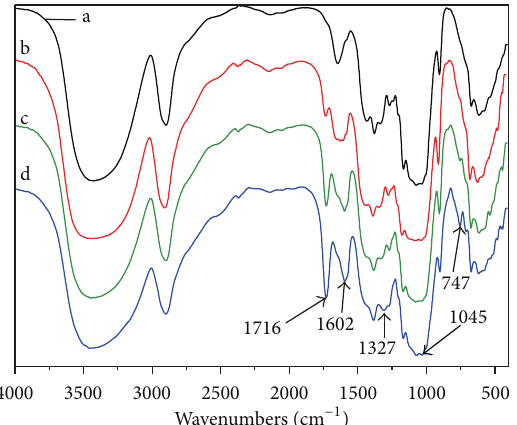
Figure 2: FT-IR spectra of unmodified cellulose (C0, spectrum a) and modified cellulose with phthalic anhydride dosage at 10 (C1, spectrum b), 30 (C3, spectrum c), and 40 (C4, spectrum d)